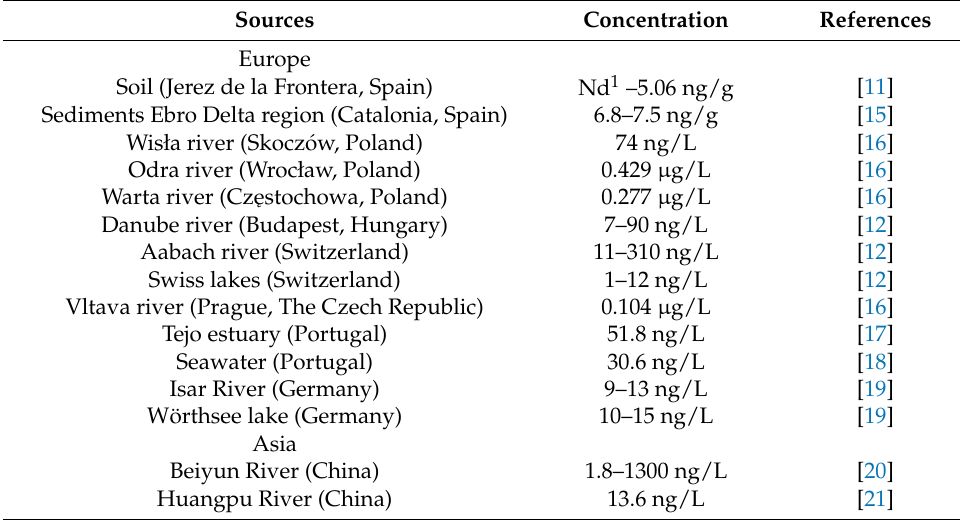
Table 1. Diclofenac concentration in the